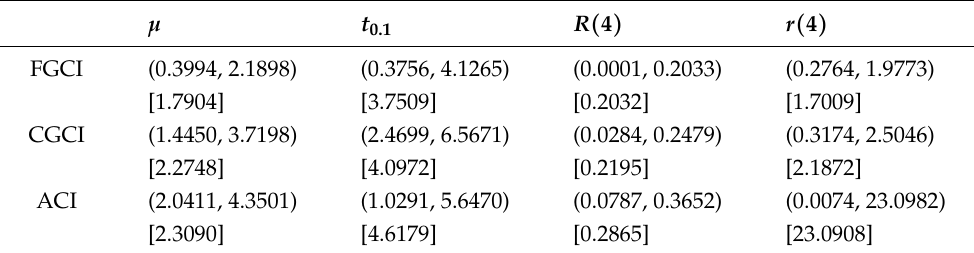
Table 4. Interval estimates of reliability indices using breakdown record data (7) of the electrical insulating